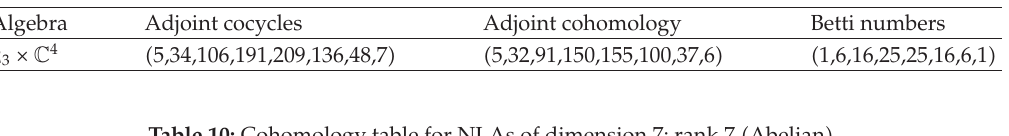
Table 9: Cohomology table for NLAs of dimension 7: rank 6.